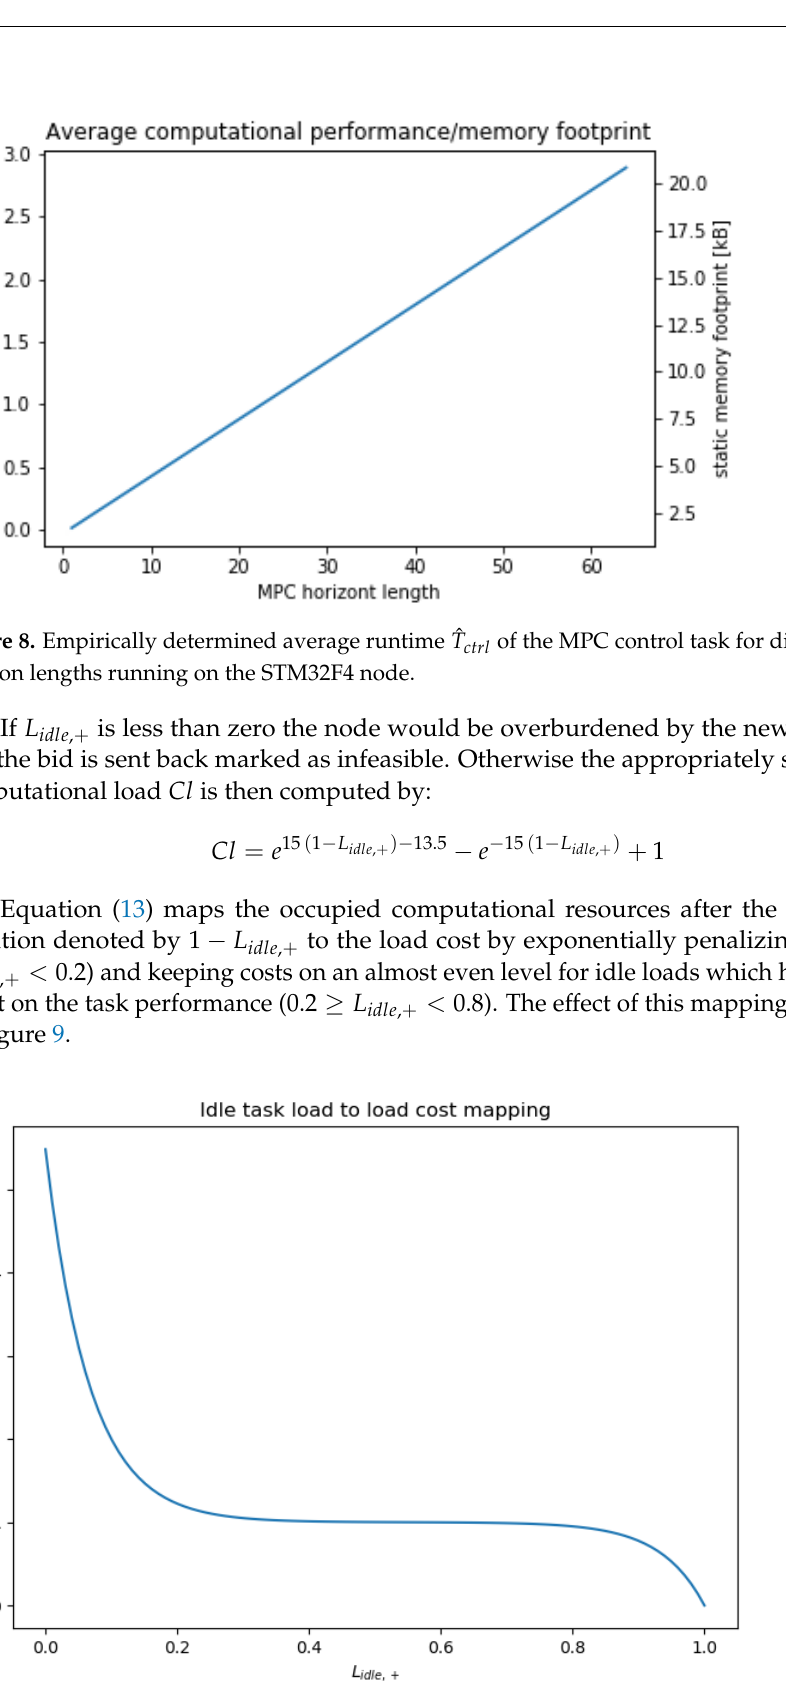
Figure 9. Mapping from free computing load after task acquisition L idle , + to bid load cost Cl